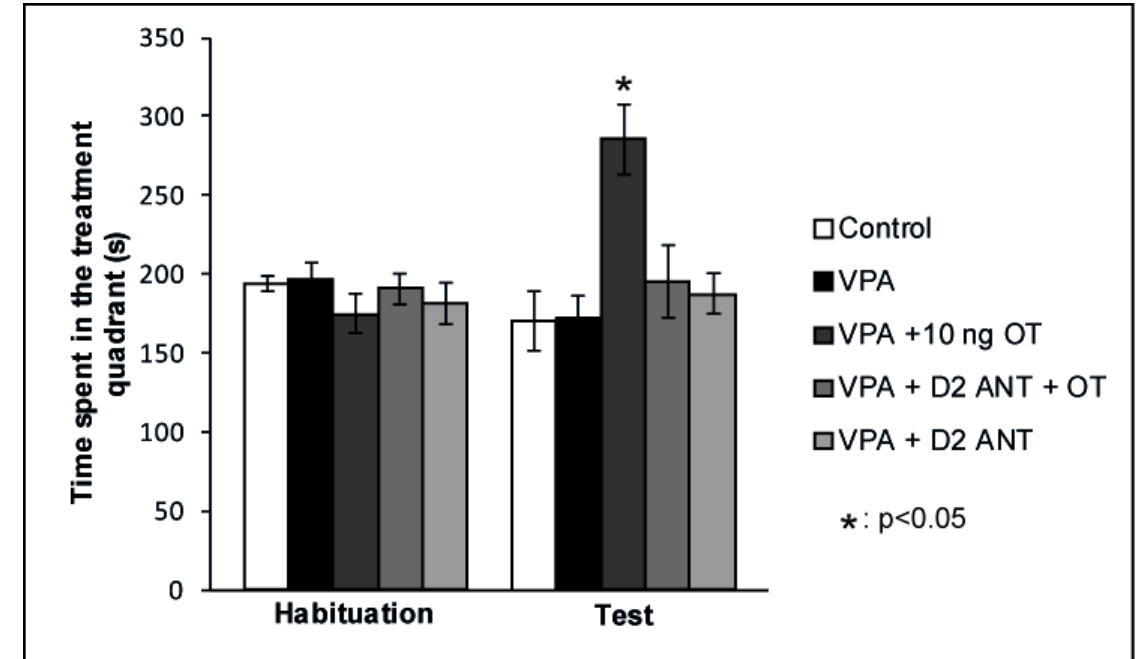
Figure 3. Effects of D2 DA antagonist pretreatment in the CeA of autistic rats on the conditioned place preference (CPP) test. Columns represent mean time spent in the treatment quadrant ( ± S.E.M.) during Habituation and Test sessions. Control: neurotypical/sham male Wistar rats receiving intraamygdaloid PBS ( n = 8); VPA: intrauterine VPA-treated rats showing autistic-like behavior ( n = 7); VPA + 10 ng OT: animals showing autistic-like behavior, microinjected with 10 ng OT ( n = 7); VPA + D2 ANT + OT: animals with autistic-like behavior, microinjected with 10 ng OT and pretreated with 4 µg Sulpiride ( n = 7); VPA + D2 ANT: animals with autistic-like behavior, treated with 4 µg Sulpiride ( n = 7); * p < 0.05, for more explanations, see the text.